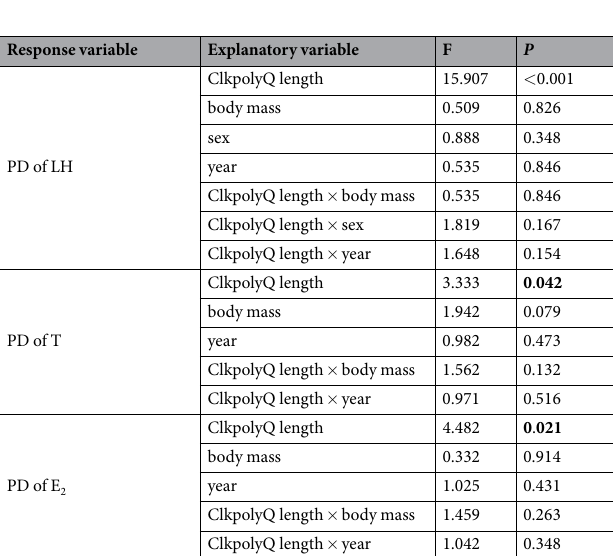
Figure 2. Variation in the dates on which ( a ) plasma LH, ( b ) T, and ( c ) E 2 , concentrations of individuals attaining the peak levels within a population of Asian short-toed larks in Inner Mongolia, China.